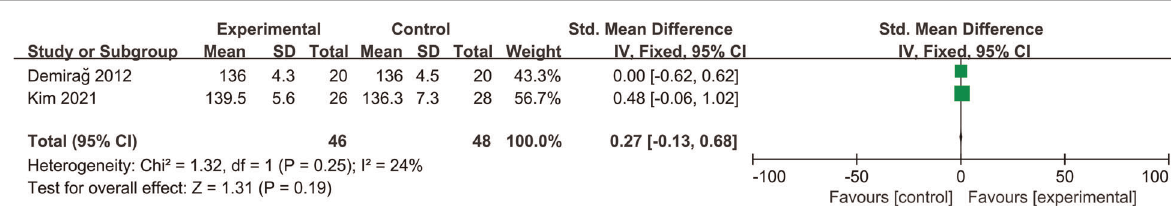
FIGURE 14 Forest pot for range of motion.